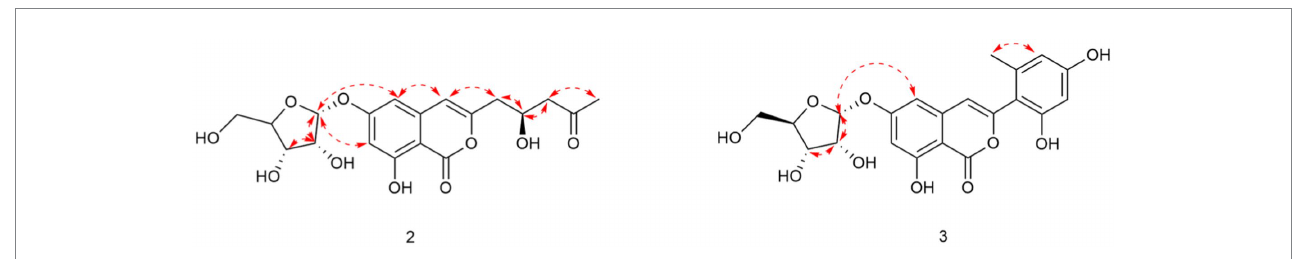
FIGURE 3 Key NOESY correlations of compounds 2 and 3